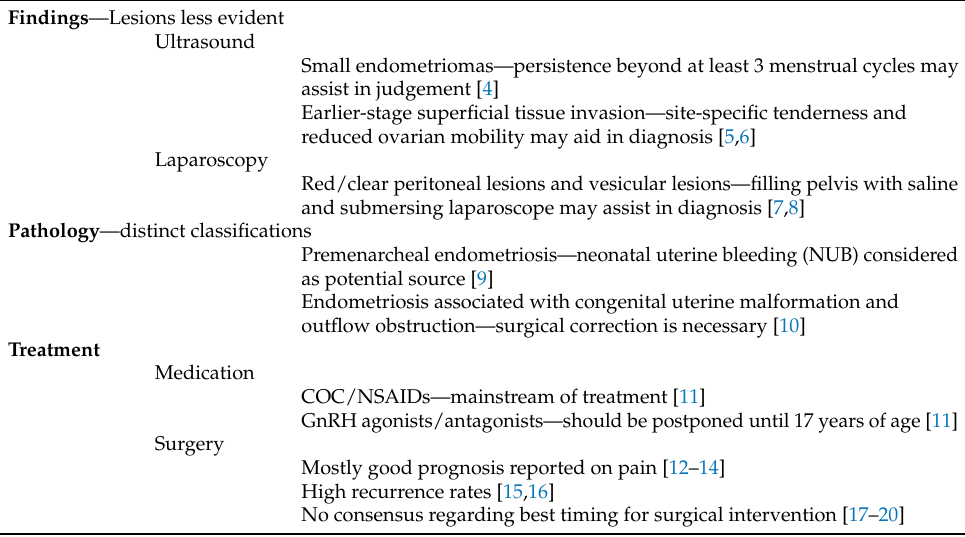
Table 1. Cont. Findings —Lesions less evident